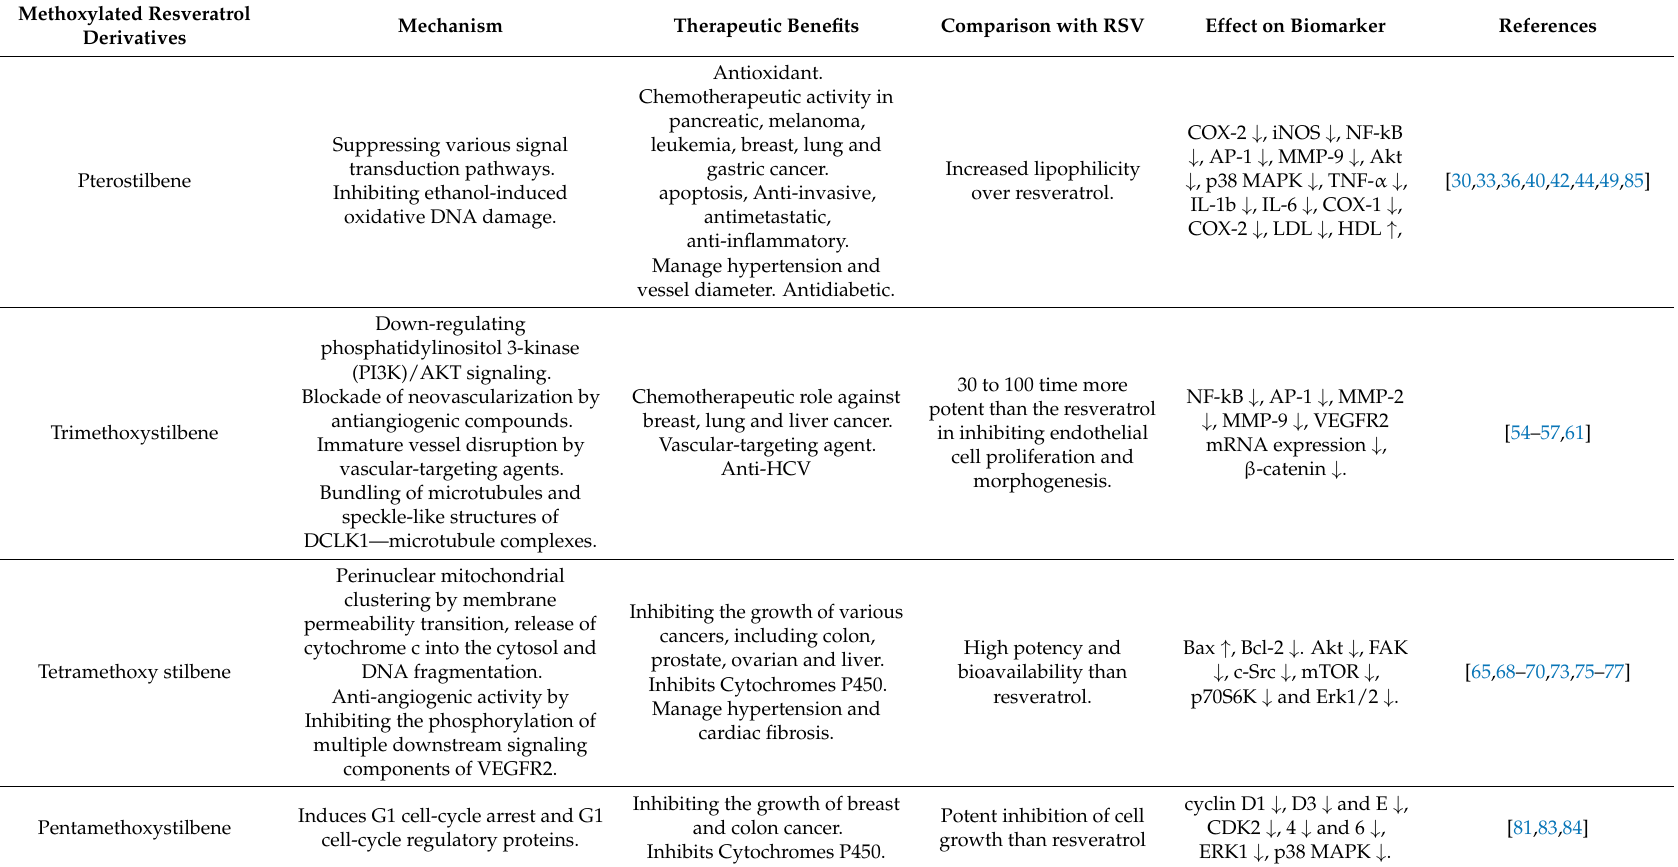
Table 1. Overview of methoxlated resveratrol derivatives, their therapeutic benefits, mechanisms and effects on various